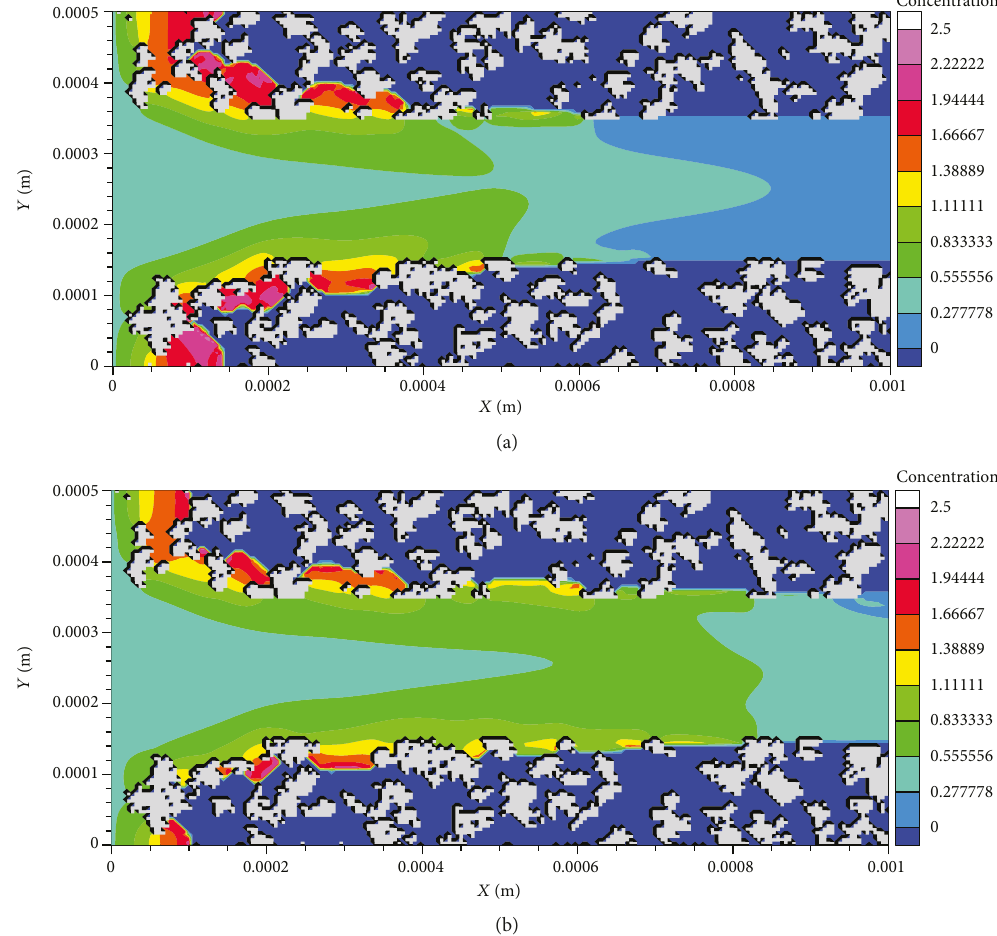
Figure 6: Concentration (mol/L) of species A when (a) Pe =26 and Da =20 and (b) Pe =26 and Da=10. In both (a) and (b), porosity (after (aq) dissolution) is near 0.50 but permeability (after dissolution) is 1.47 × 10 − 9 m 2 for (a) and 1.56 × 10 − 9 m 2 for (b). The nonreactive minerals are illustrated in light gray. The areas showing a zero concentration of species A are representing reactive minerals. (aq)